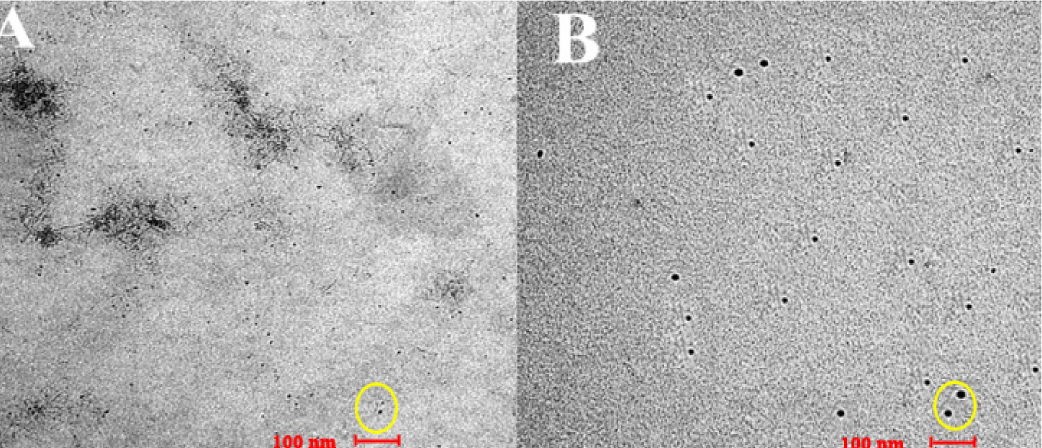
Figure 6. ( A ) The transmission electron microscope (TEM) image for blank chitosan–alginate nanopar- ticles and ( B ) the TEM image of nerolidol-loaded chitosan–alginate nanoparticles. The yellow circle on both figures shows the sphere-like